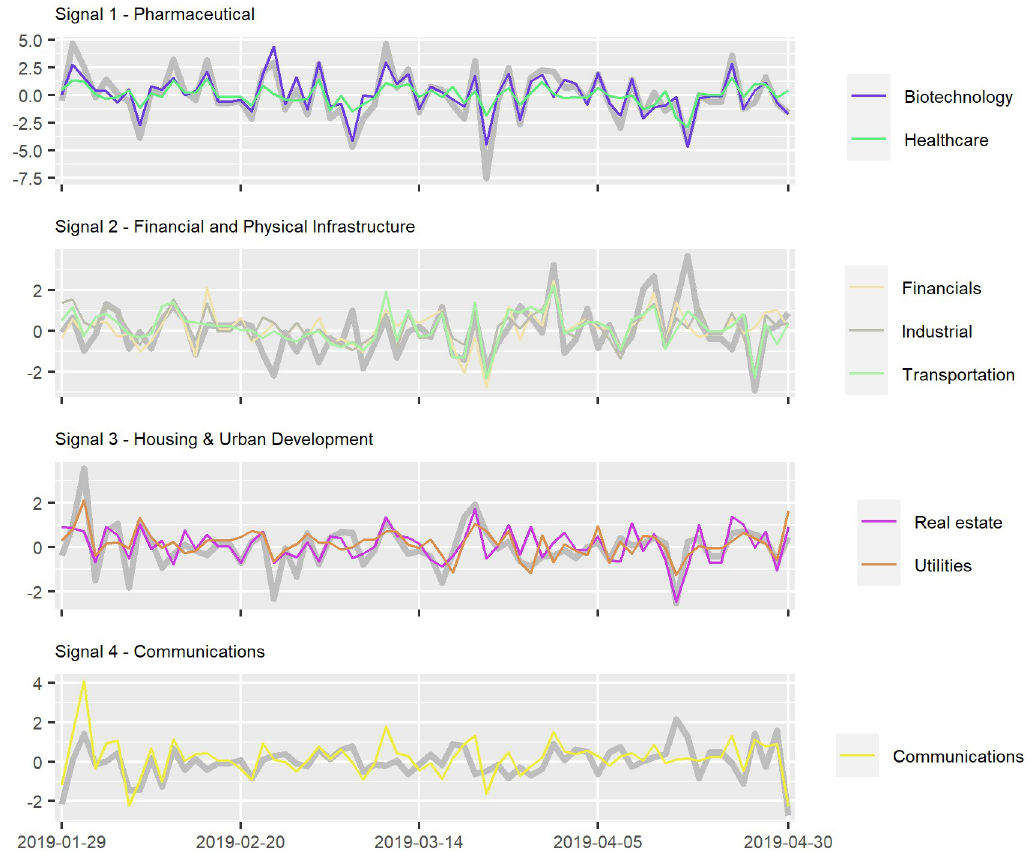
Fig 3. Signals (thick grey lines) plotted together with their most highly correlated